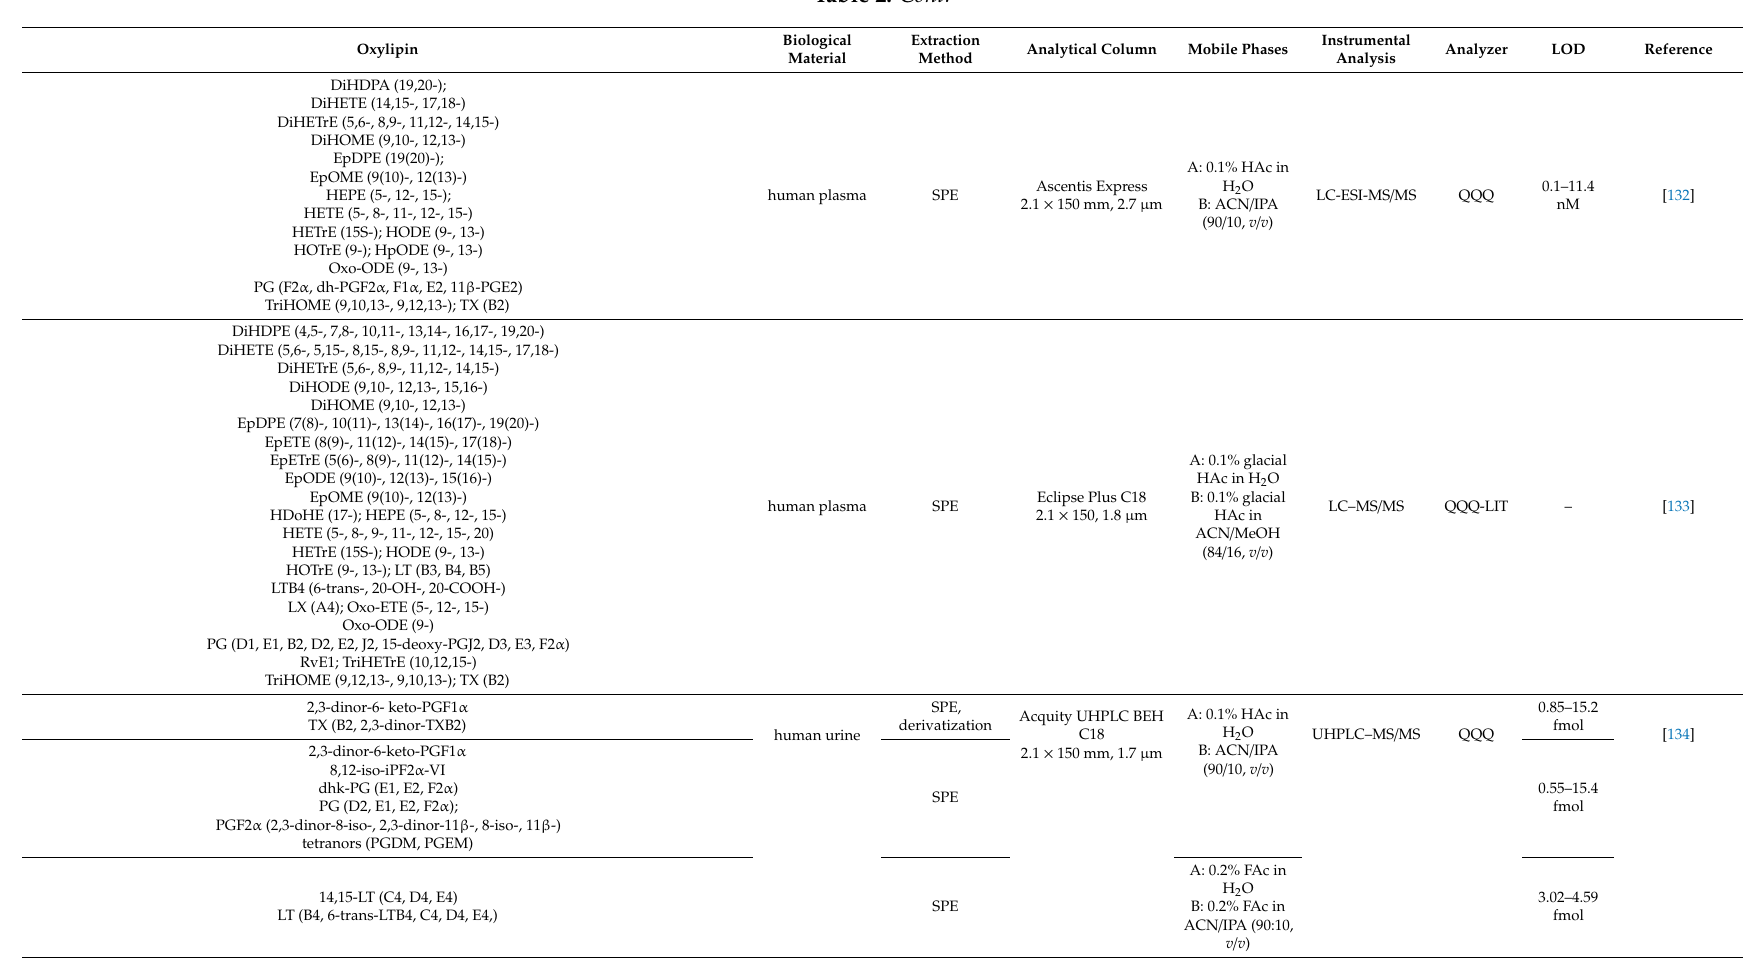
Table 2. Cont. Oxylipin Biological Material Extraction Method Analytical Column Mobile Phases Instrumental Analysis Analyzer LOD